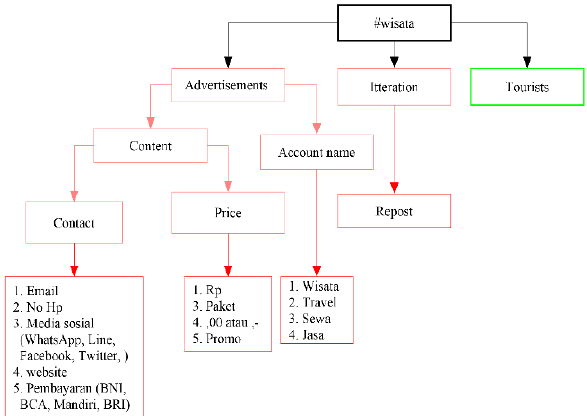
Figure 3.1 Data cleaning pattern using